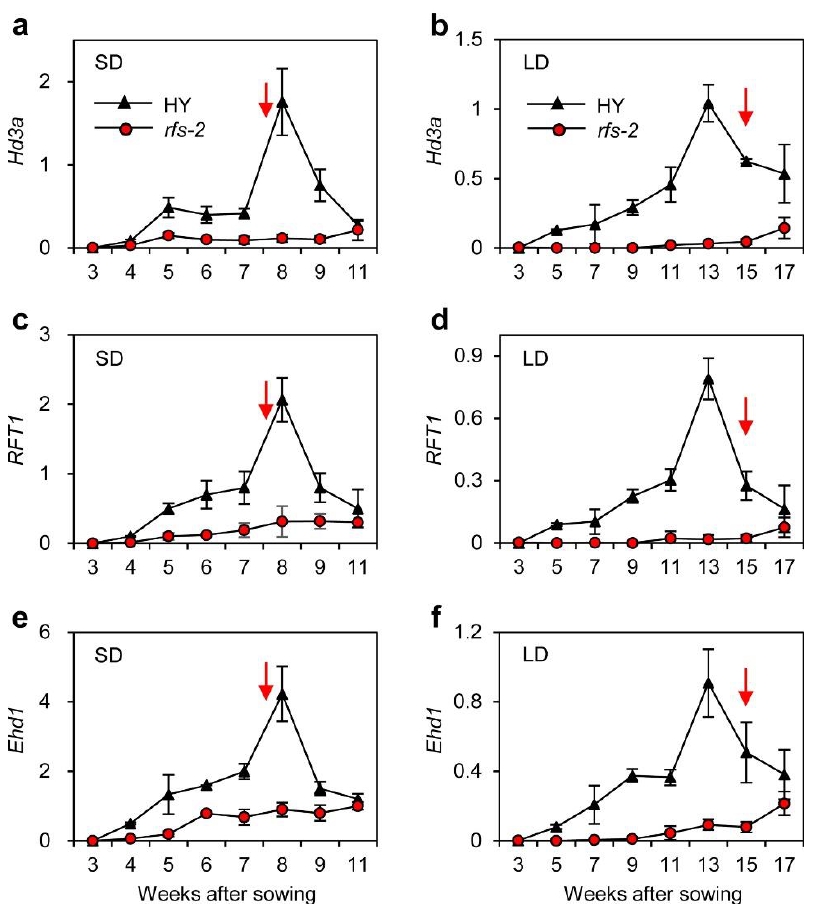
Figure 3. Altered expression of flowering genes in the rfs-2 mutant during plant development. Total RNA was isolated from HY and rfs-2 leaf blades collected 1 h after dawn (ZT1) in SD ( a , c , e ) and LD ( b , d , f ) conditions. Transcript levels of Hd3a ( a , b ), RFT1 ( c , d ), and Ehd1 ( e , f ) were determined by RT-qPCR and normalized to that of OsUBQ5 ( LOC_Os01g22490 ). Means and standard deviations were obtained from three biological replicates. Experiments were repeated three times with similar results. Red arrows indicate the average flowering date of HY.